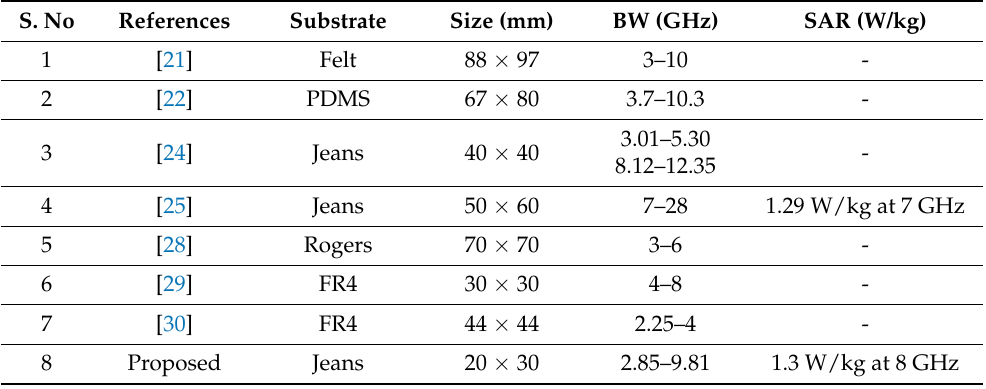
Table 2. Comparison with existing